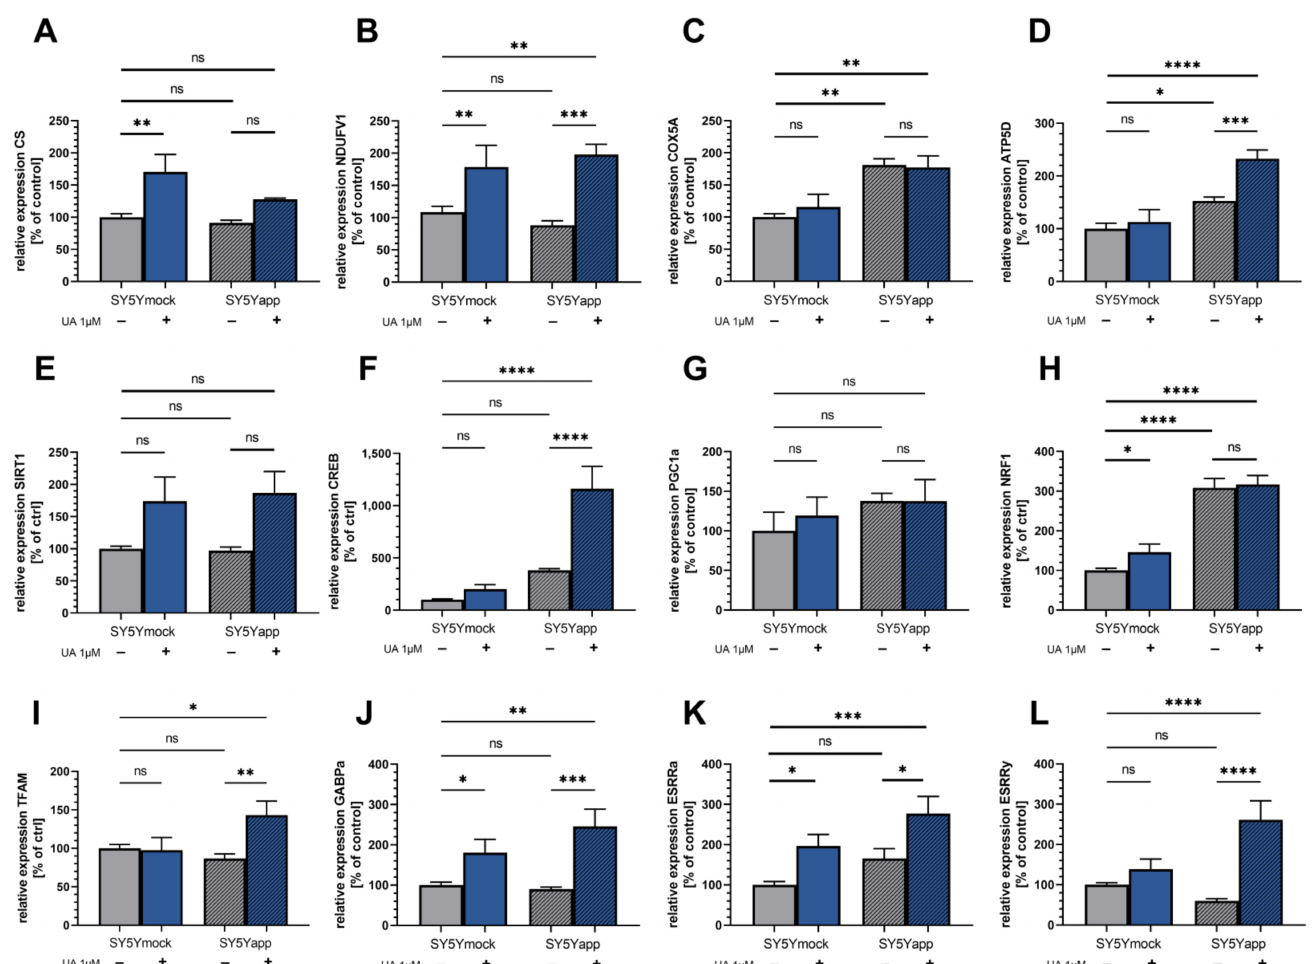
Figure 4. Relative normalized mRNA expression of relevant genes relevant to OXPHOS and mitochondrial biogenesis. Genes related to OXPHOS: ( A ) citrate synthases (CS), ( B ) complex I (NDUFV1), ( C ) complex IV (COX5D), and ( D ) complex V (ATP5D). Genes related to mitochondrial biogenesis: ( E ) Sirtuin 1 (SIRT1), ( F ) cAMP response element-binding protein ranscription factor (CREB), ( G ) Peroxisome proliferator-activated receptor gamma coactivator 1-alpha (PGC1 α ), ( H ) nuclear respiratory factor 1 (NRF1), ( I ) mitochondrial transcription factor A (TFAM), ( J ) GA Binding Protein Transcription Factor Subunit Alpha (GABP α /NRF2), ( K ) estrogen-related receptor alpha (ESRR α ), ( L ) estrogen-related receptor gamma (ESRR γ ). Displayed are data of SY5Ymock and SY5Y-APP695 cells which were measured seperately from each other. Data of both cell lines is adjusted to aged SY5Ymock ctrl group = 100%; N = 8–10; Displayed are means ± SEM; Statistical significance was tested via two-way ANOVA followed by a false discovery rate correction (FDRC) according to Benjamini, Krieger, and Yekutieli. Results were normalized to the mRNA expression levels of three housekeeping genes (beta-actine (ACT β ), Glyceraldehyde 3-phosphate dehydrogenase (GAPDH) and Phosphoglycerate Kinase 1 (PGK1)) according to the MIQE guidelines. Significance is displayed as: ns p > 0.05, * p < 0.05, ** p < 0.01, *** p < 0.001 and **** p < 0.0001. List of all statistical parameters and comparisons can be found in Supplementary Table